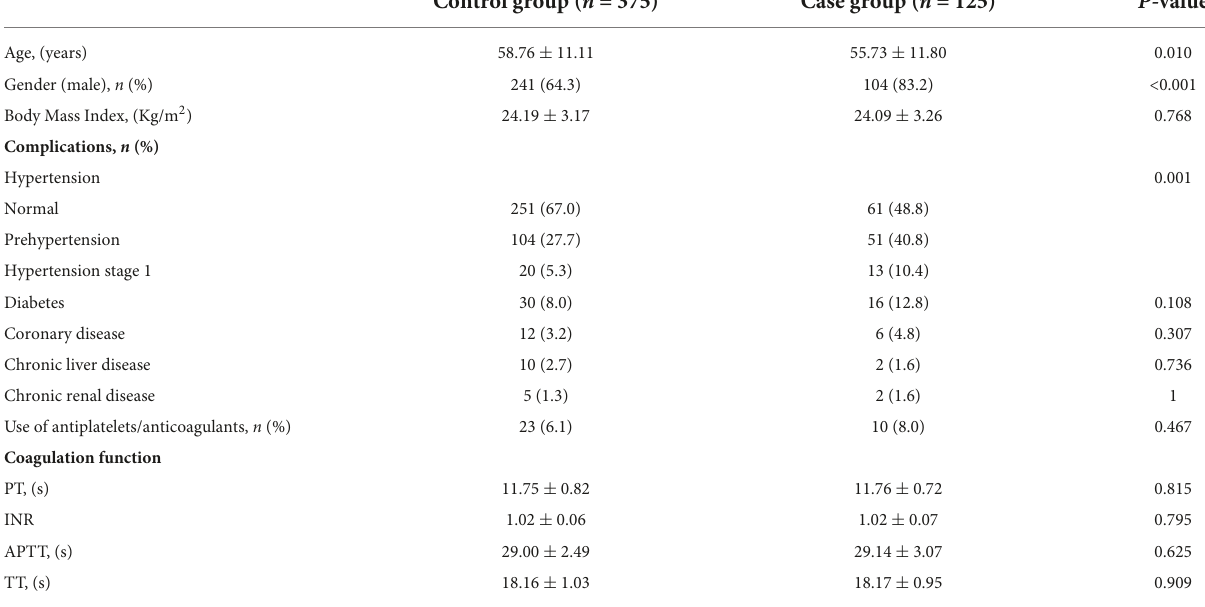
TABLE 1 Baseline characteristics of study patients.